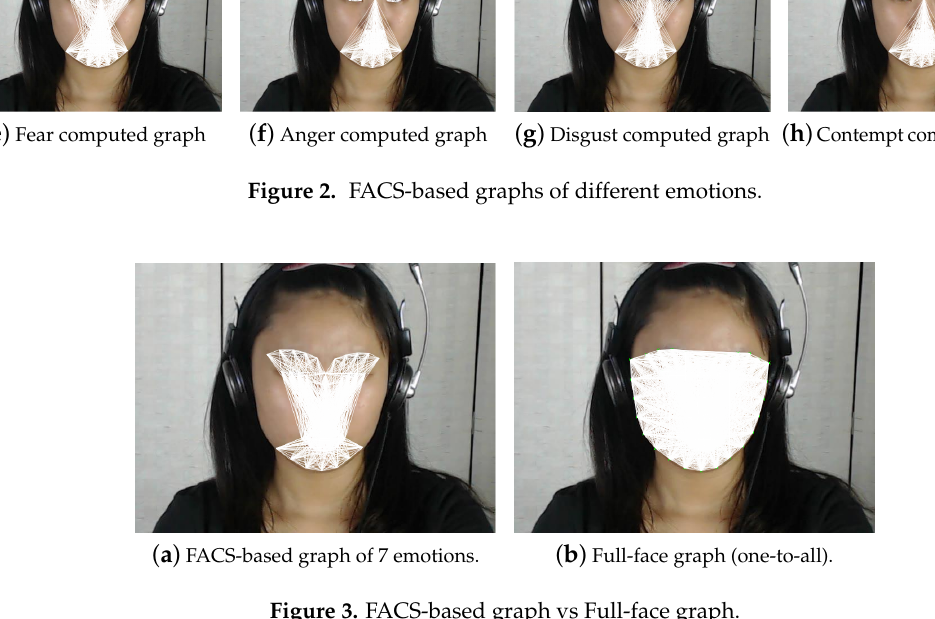
Figure 3. FACS-based graph vs Full-face